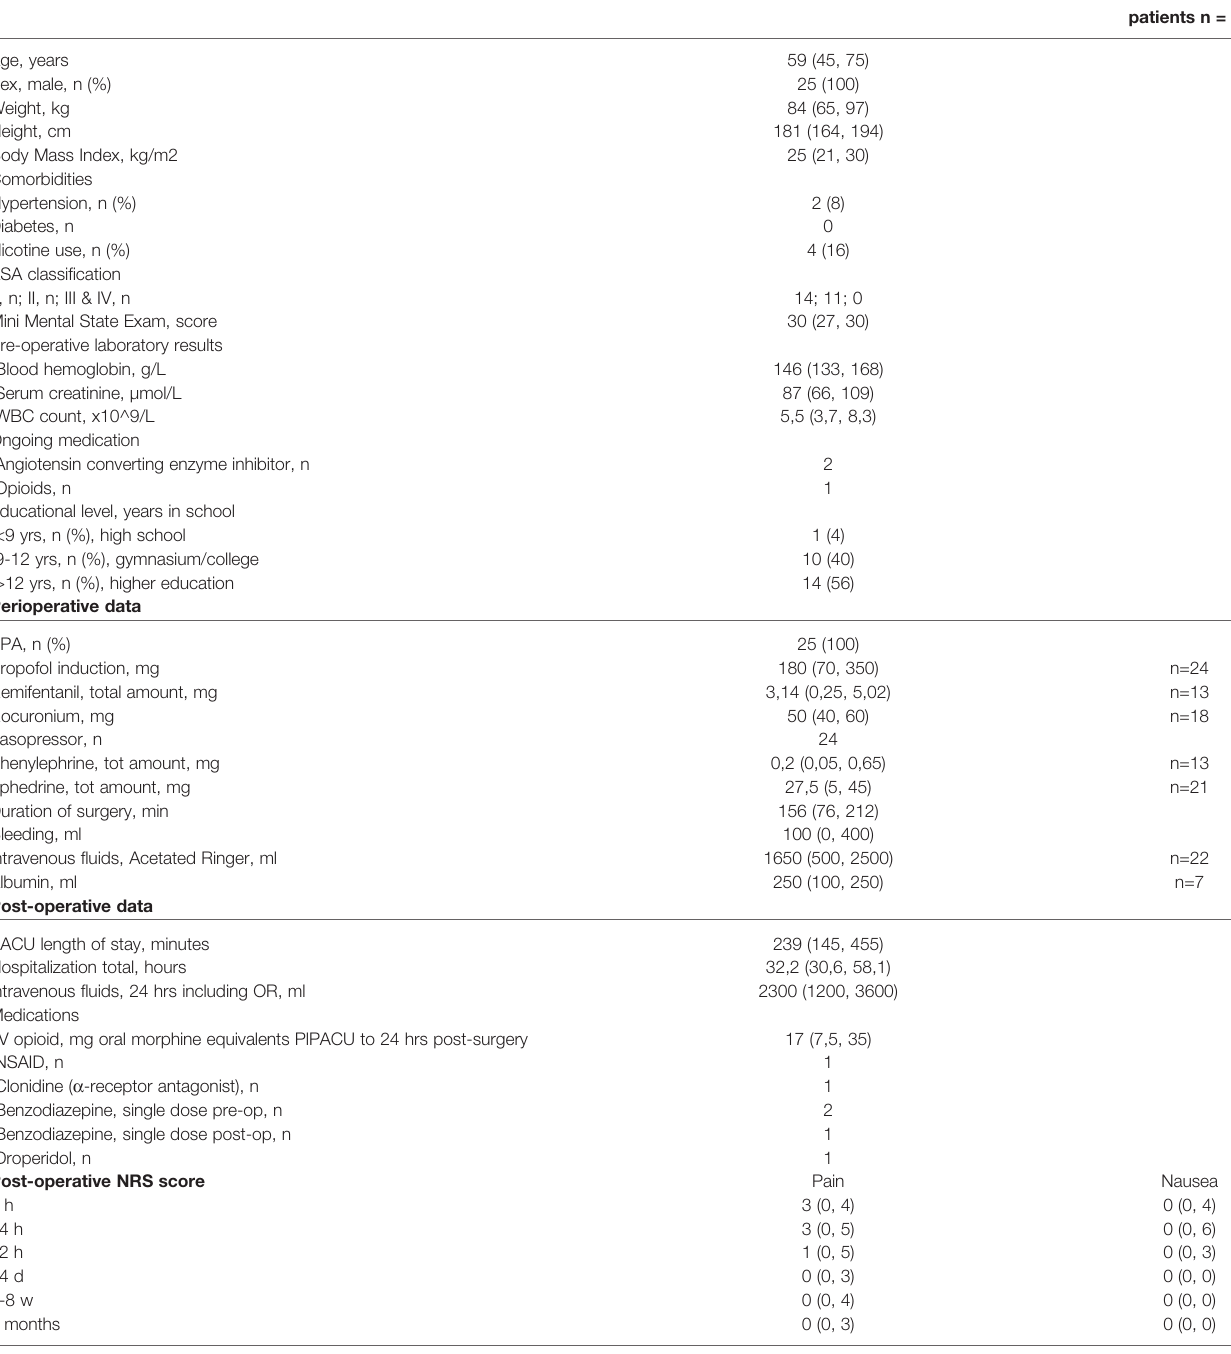
TABLE 1 | Patient characteristics and perioperative data.